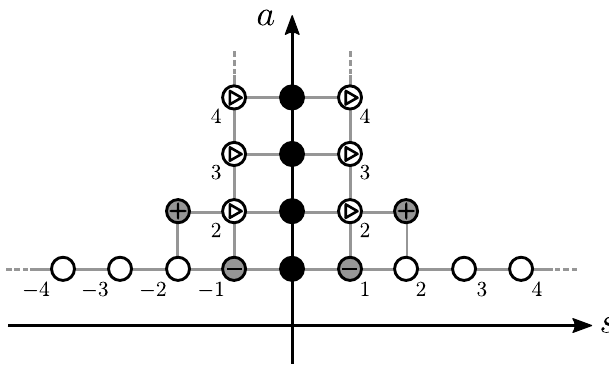
Figure 33 . Bound state Y -functions and Y -functions in the T-hook. Y -functions in N = 4 SYM are de(cid:12)ned for each node of the T-hook shown above. The identi(cid:12)cation with the bound-state label can be read o(cid:11) from the symbols at each